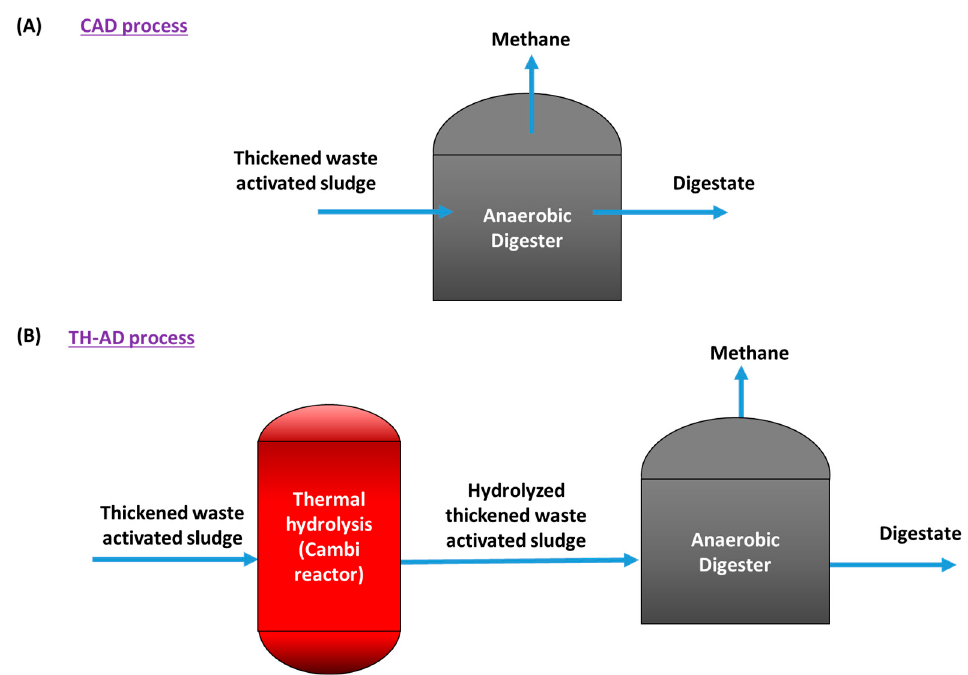
Figure 1. Schematic view of ( A ) CAD process and ( B ) TH-AD process.